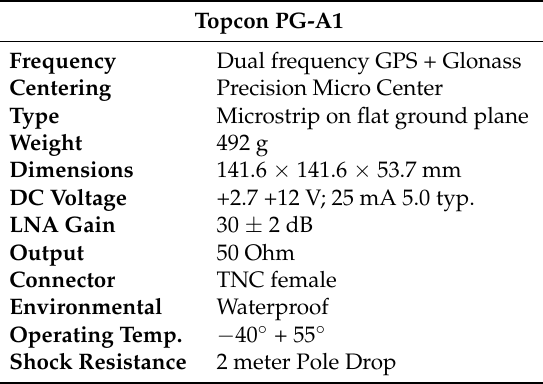
Table 1. Topcon PG-A1 antenna characteristics.